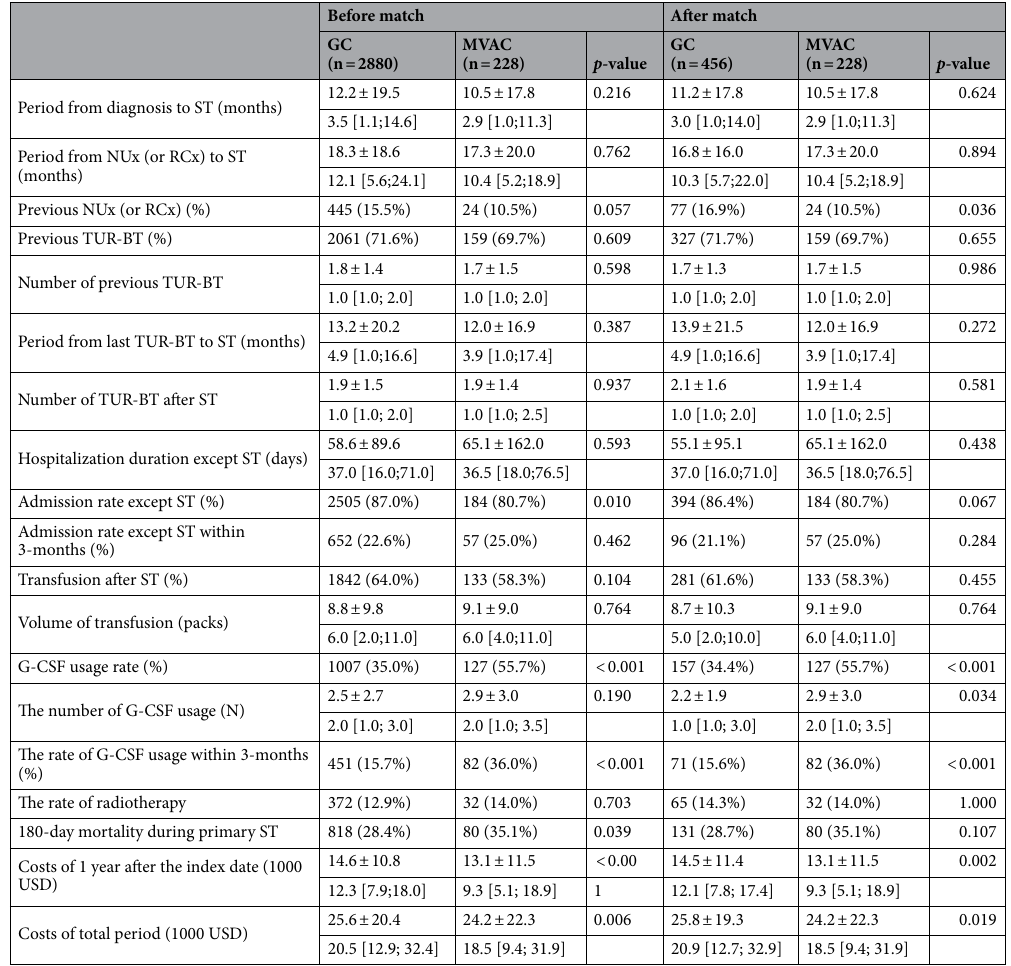
Table 2. Clinical trends after the treatments. Data are presented as n (%), mean ± standard deviation, or median [interquartile range]. GC, Gemcitabine + Cisplatin Chemotherapy; MVAC, Methotrexate + Vinblastine + Doxorubicin + Cisplatin Chemotherapy; ST, systemic therapy; NUx, Nephroureterectomy; RCx, Radical cystectomy; TUR-BT, Transurethral resection of bladder tumor; G-CSF, Granulocyte colony-stimulating factor; UDS, United States